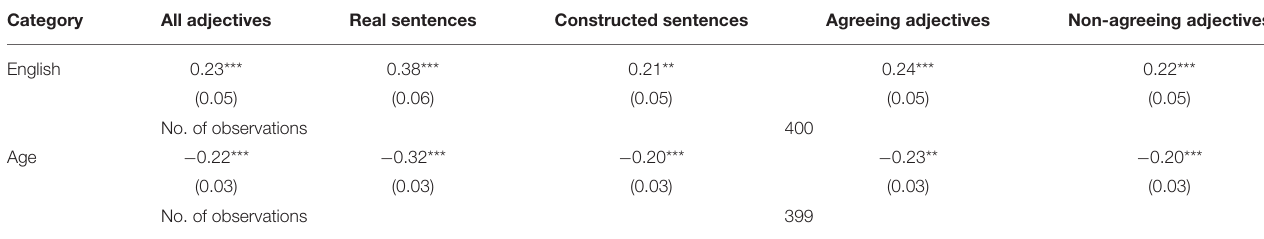
TABLE 3 | Regression results between acceptability rates across categories and two factors: proficiency in/exposure to English and age.